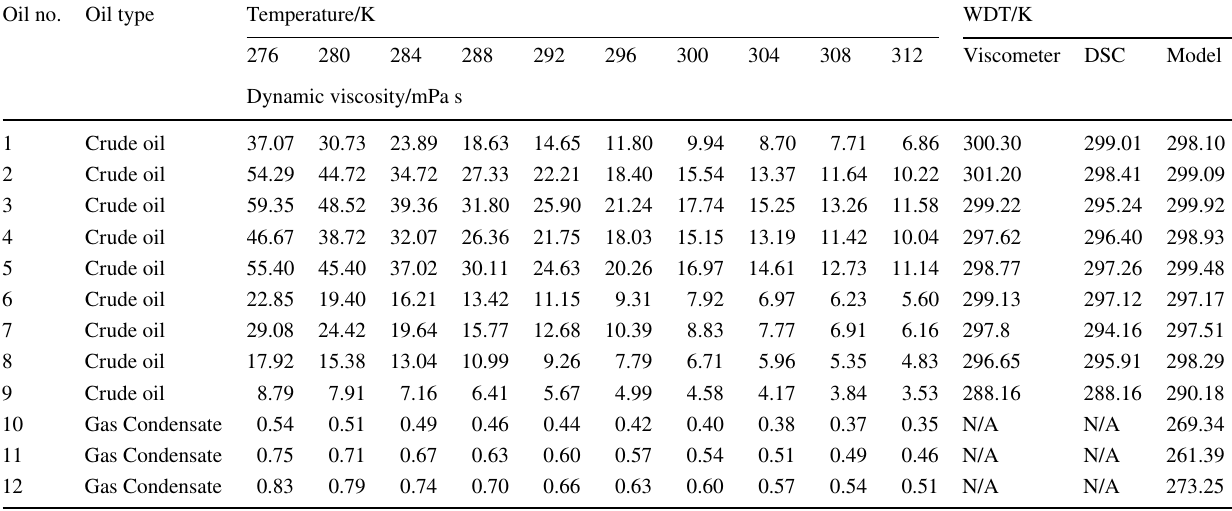
Table 9 Measured viscosity data and comparison of experimental and predicted WDT for 12 crude oils and condensates Oil no. Oil type